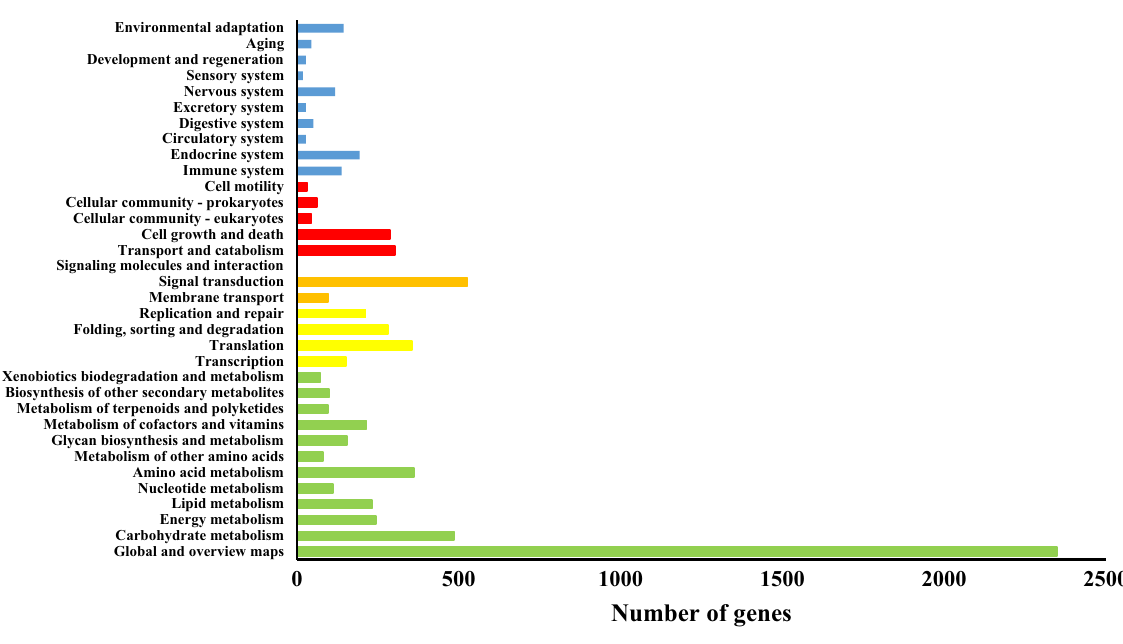
Figure 2. The result of annotation in GhostKOALA (green: Metabolism, yellow: Genetic Information Processing, orange: Environmental Information Processing, red: Cellular Processes and blue: Organismal